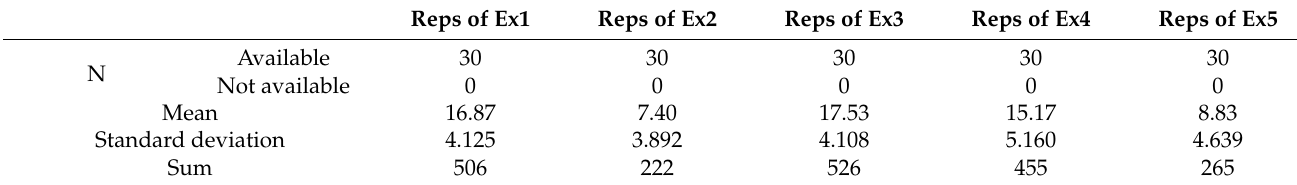
Table 4. Statistical analysis of exercise repetitions